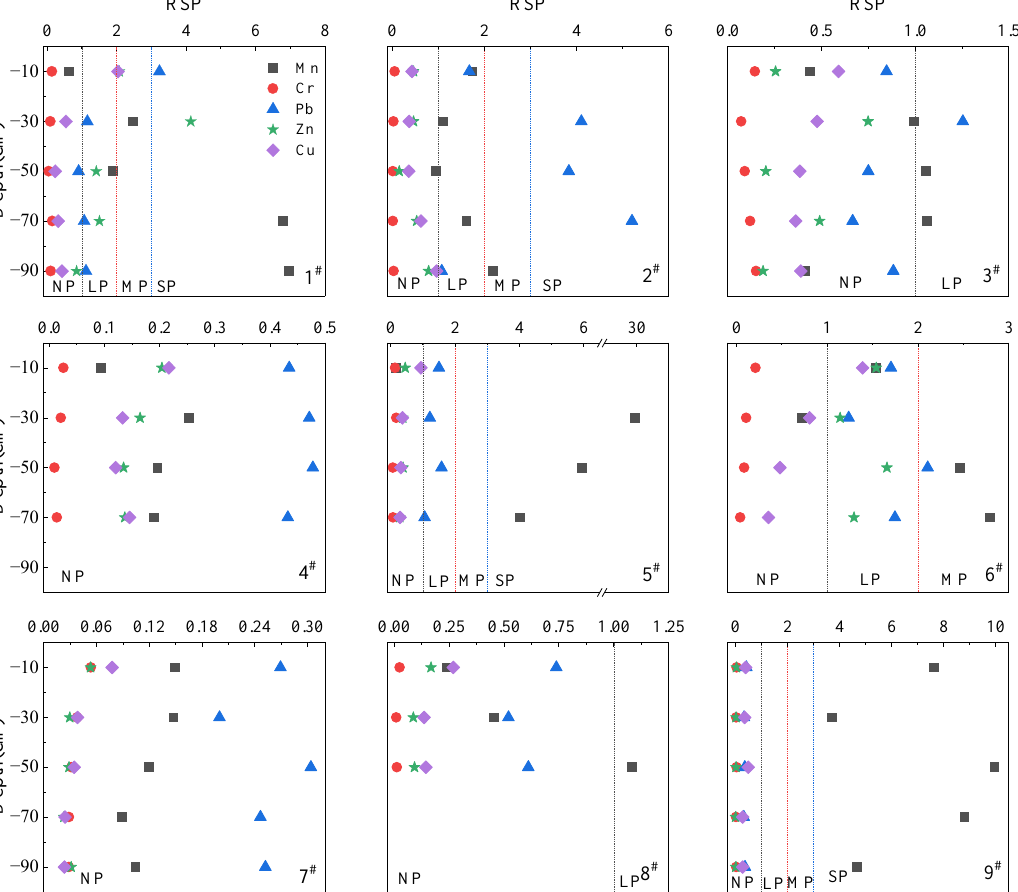
Figure 6. The degree of heavy metal pollution in the study area. (Note: different color lines represent RSP values: 1, 2, 3; NP: no pollution; LP: light pollution; MP: moderate pollution; SP: severe pollution; SIP: significant contamination; the black square represents Mn, the red dot represents Cr, the blue triangle represents Pb, the green pentagram represents Zn, and the purple diamond represents Cu).